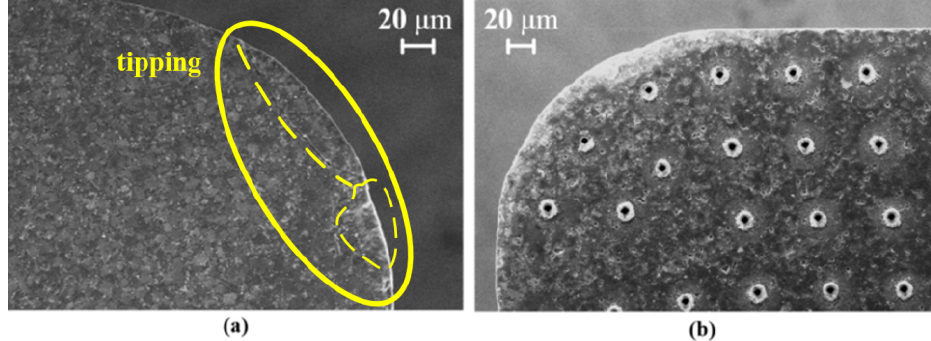
Figure 16. The SEM images of ( a ) non-textured PCD tool and ( b ) textured tool after 10 turnings.